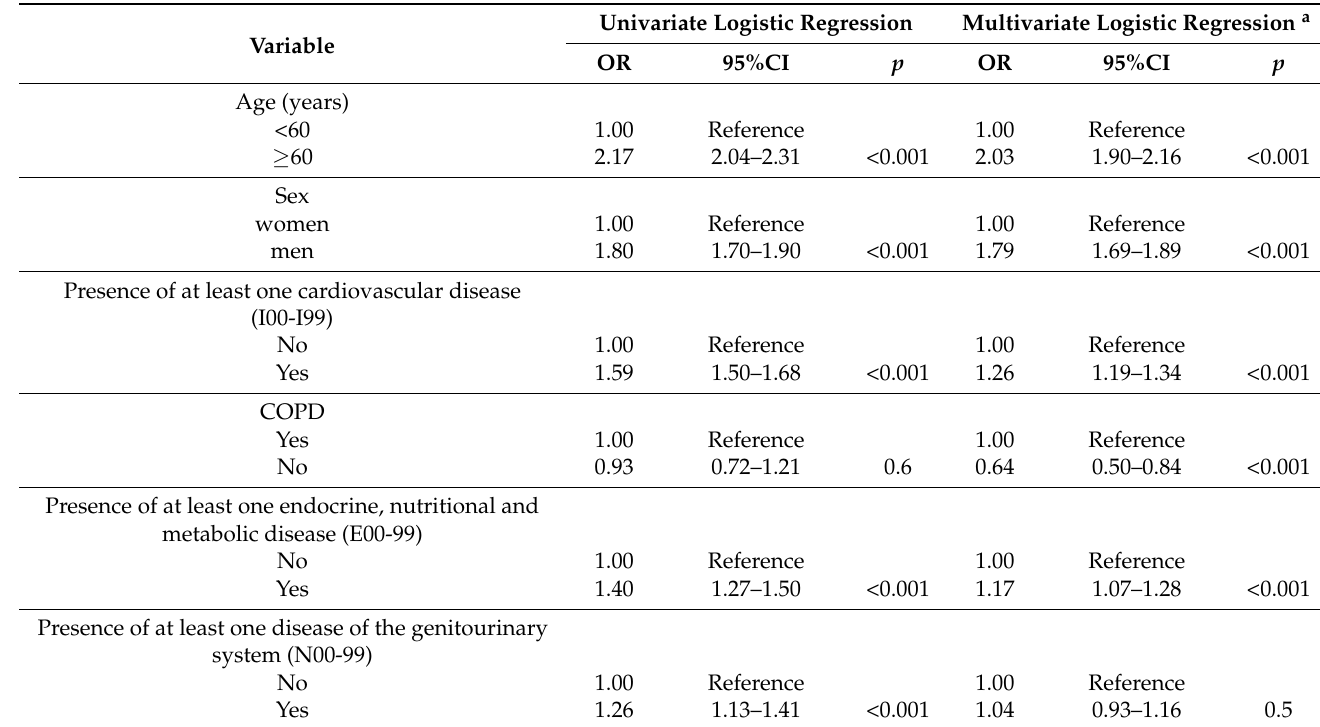
Table 4. Odds ratios (OR) and 95% confidence intervals (CI) for admission to the intensive care unit (ICU) to selected factors in a group of 116,539 patients hospitalized with COVID-19—Poland, March–December 2020.